Question: Condense the content of this figure into a single sentence.
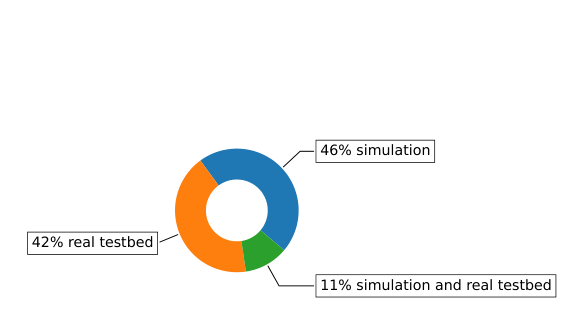
Answer: Percentages of research articles evaluating their methods by simulation, real testbed, or both tools.